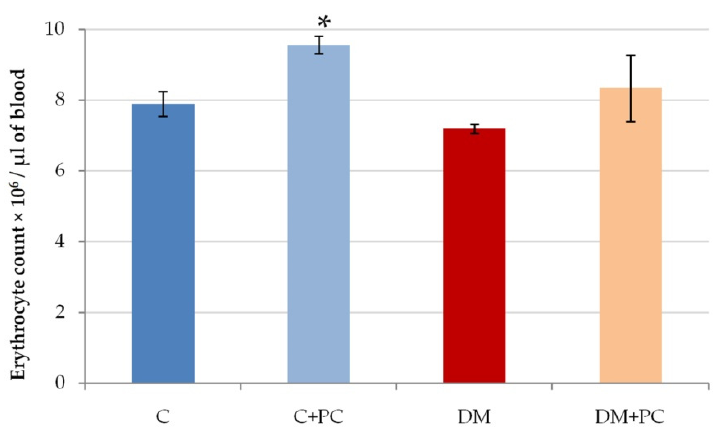
Figure 3. The content of glycated hemoglobin in peripheral blood of control rats, rats with experimental diabetes mellitus, with and without PC concentrate. C–normal untreated control animals; C + PC–animals that were per os administrated PC concentrate (daily dose of 45 mg/kg bw of polyphenolic complex for 14 days); DM – rats with experimental diabetes mellitus; DM + PC–animals with experimental diabetes mellitus that were per os administrated PC concentrate (daily dose of 45 mg/kg bw of polyphenolic complex for 14 days). *-significant difference compared to control ( p < 0.05); #-significant difference compared to diabetes mellitus ( p < 0.05).